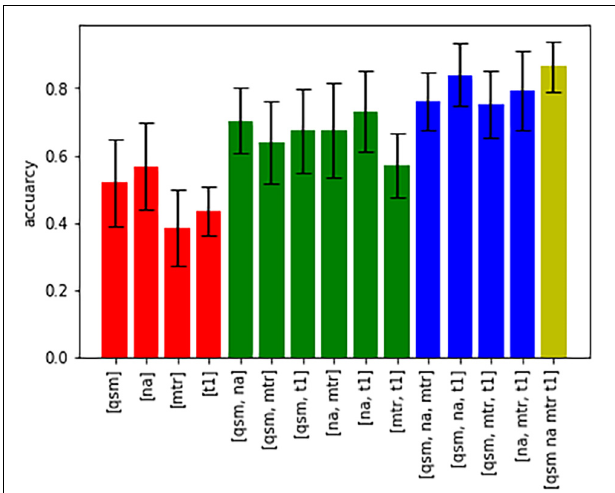
FIGURE 5 | Bar graphs showing the accuracy of characterization of all nuclei based on different combinations of contrasts.